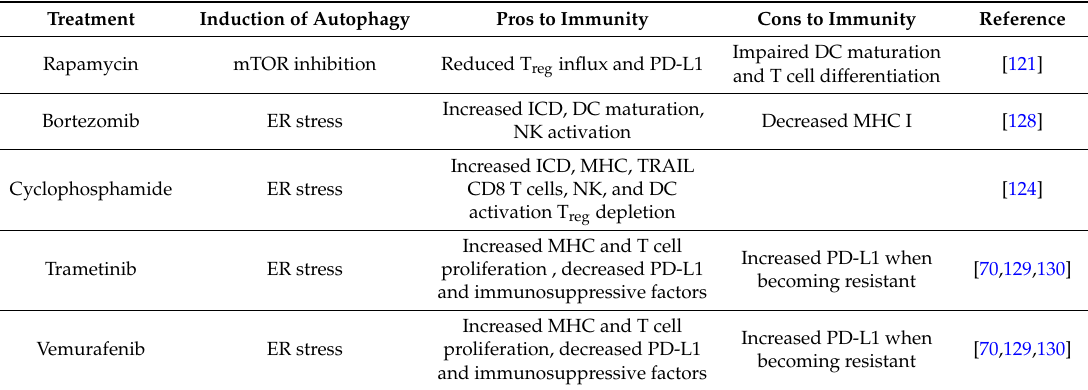
Table 2. The influence of autophagy induced by current anticancer agents on